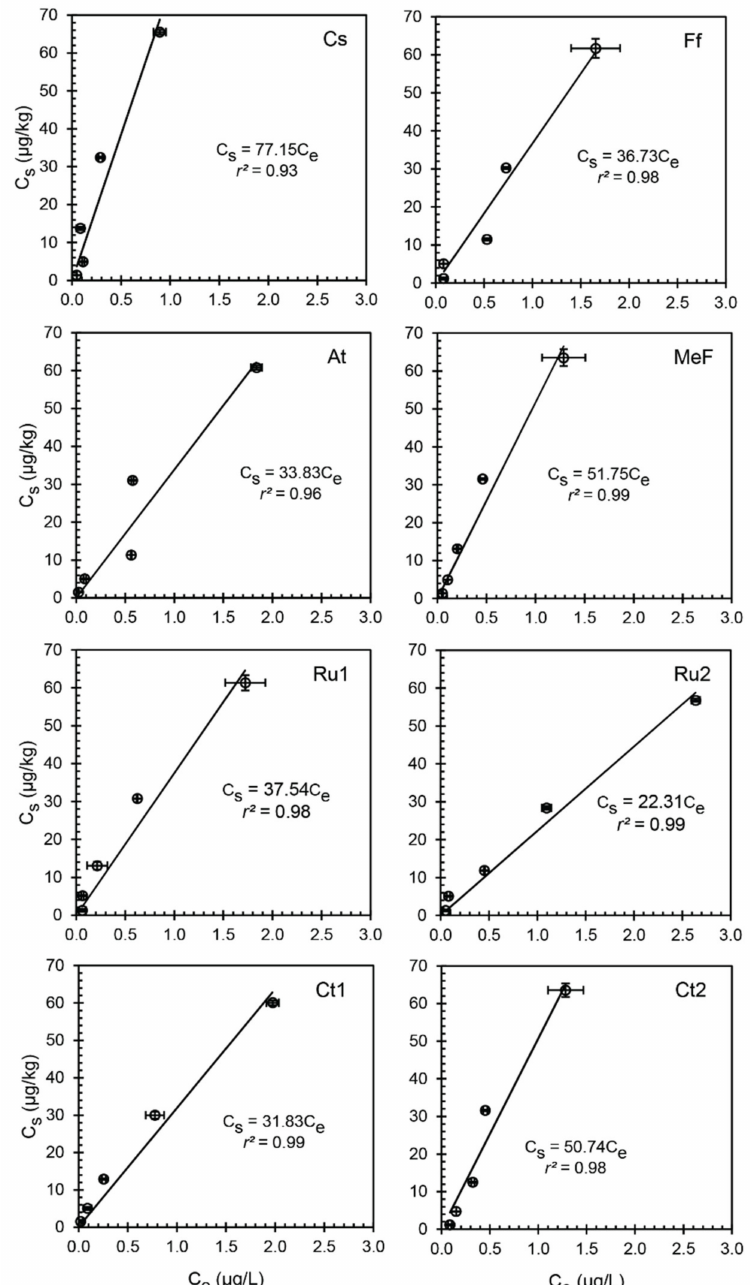
Figure 2. Sorbed (C s ) and aqueous equilibrium (C e ) concentrations for each sample (error bars represent ± 1 standard deviation; At, Alligator Association; Cs, channel sand; Ct1, Cuthbert Series A horizon; Ct2, Cuthbert Series B horizon; Ff, Falaya Silt Loam Series; MeF, Memphis Silt Loam Series; Ru1, Ruston Series A horizon; Ru2, Ruston Series E